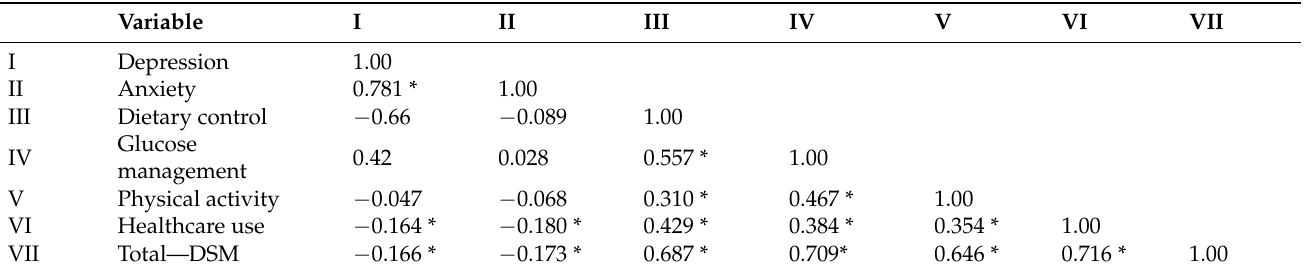
Table 5. Correlation between psychological health and diabetes self-management among participants ( n =